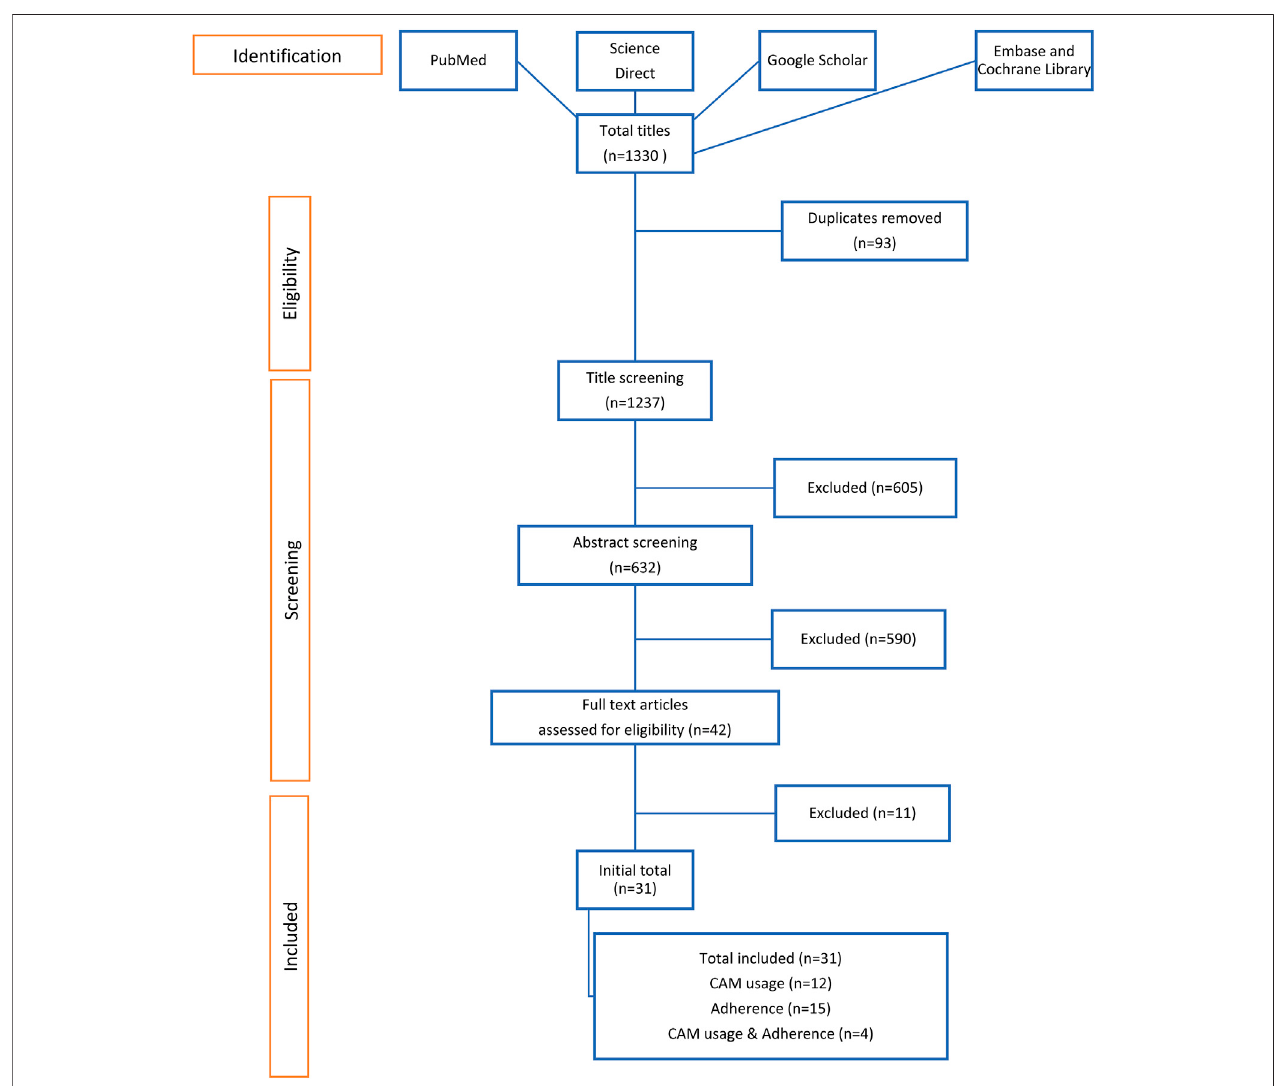
FIGURE 1 | Flow diagram of searches and inclusion assessment of